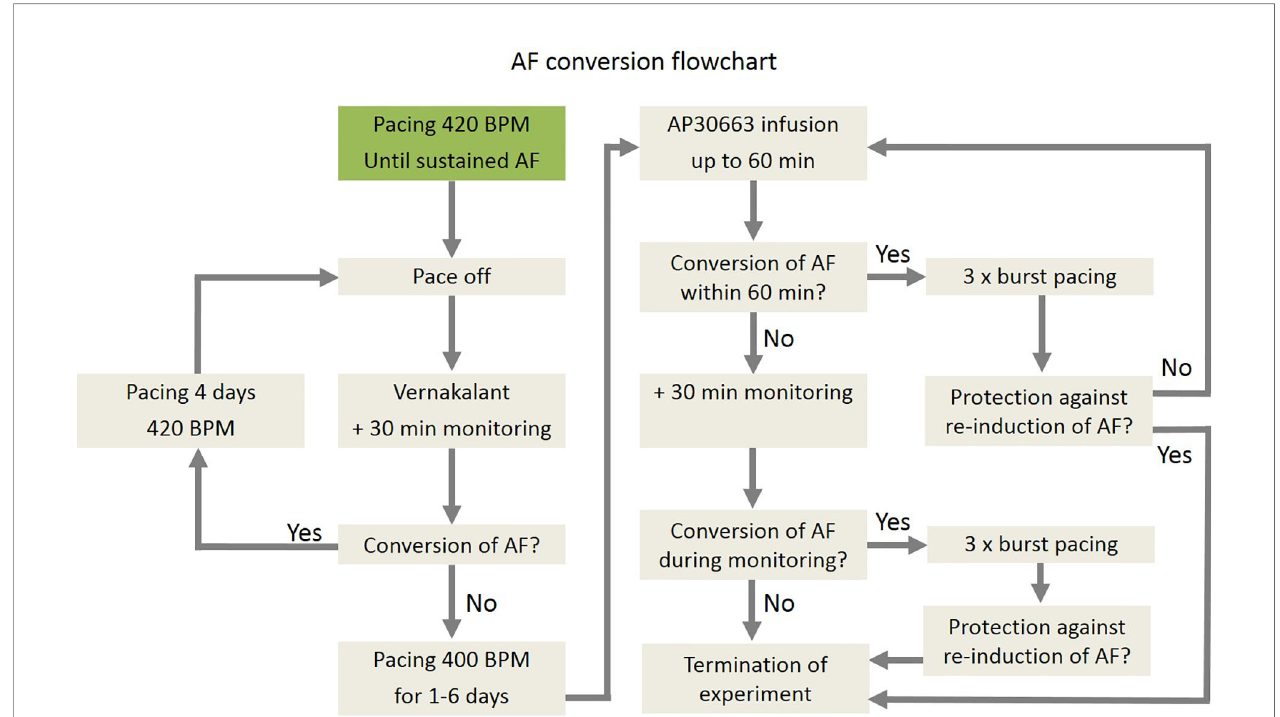
FIGURE 2 | Flow chart of induction of AF, cardioversion of AF, and reinduction of AF in